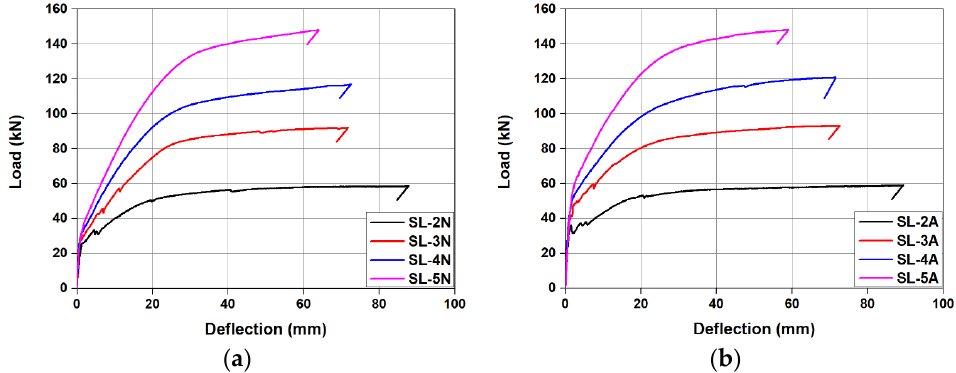
Figure 10. Comparison of load – deflection curves according to activation of Fe-SMA rebar: ( a ) SL-2N and SL-2A, ( b ) SL-3N and SL-3A, ( c ) SL-4N and SL-4A, and ( d ) SL-5N and SL-5A.